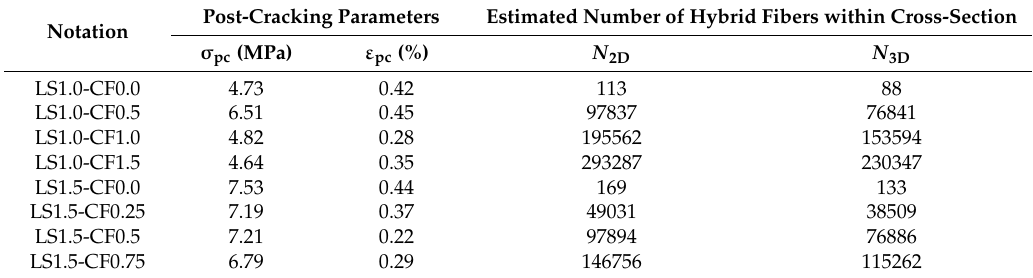
Figure 18. Comparative gauge factors of studied MSFRCs: ( a ) for MSFRC1 group; ( b ) for MSFRC2 group.